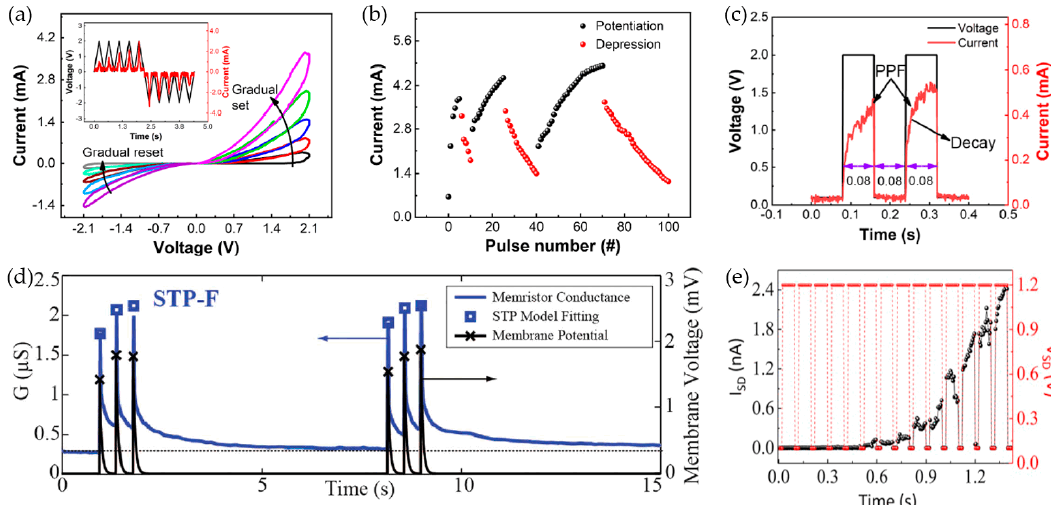
Figure 12. ( a ) Potentiation and depression response of Ag/SiO x :Ag/TiO x /p ++ -Si device with repeated voltage sweeps. ( b ) Conductance modulation and ( c ) PPF of Ag/SiO x :Ag/TiO x /p ++ -Si device by repeating consecutive pulses. ( d ) Repeated STP response with the model fitting of TiO x -based RRAM device, reproduced from [158], with permission from Springer Nature, 2020. ( e ) Synaptic facilitation response to consecutive pulses of the device with h-BN, reproduced from [159], with permission from Elsevier, 2020.